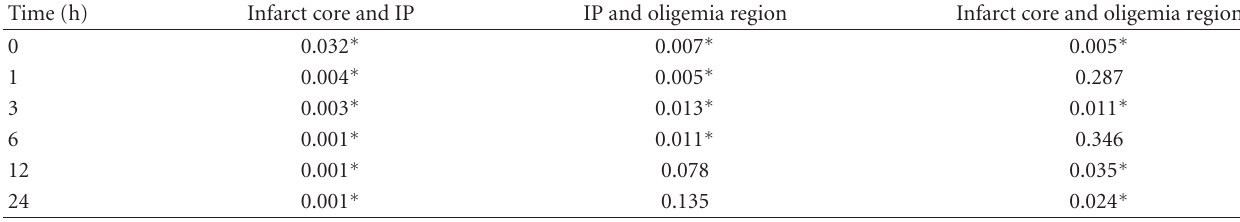
Table 4: ANOVA among brain temperature of di ff erent ischemic tissues and contralateral hemisphere in monkey MCAO model ( P value).